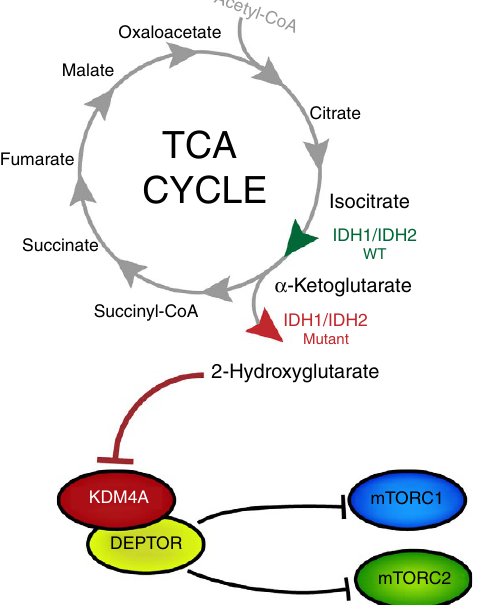
Figure 5 | Non-canonical regulation of mTOR activity by 2HG-mediated inhibition of KDM4A. Simplified schematic model for mTOR activation following KDM4A inhibition by IDH1/2 gain-of-function